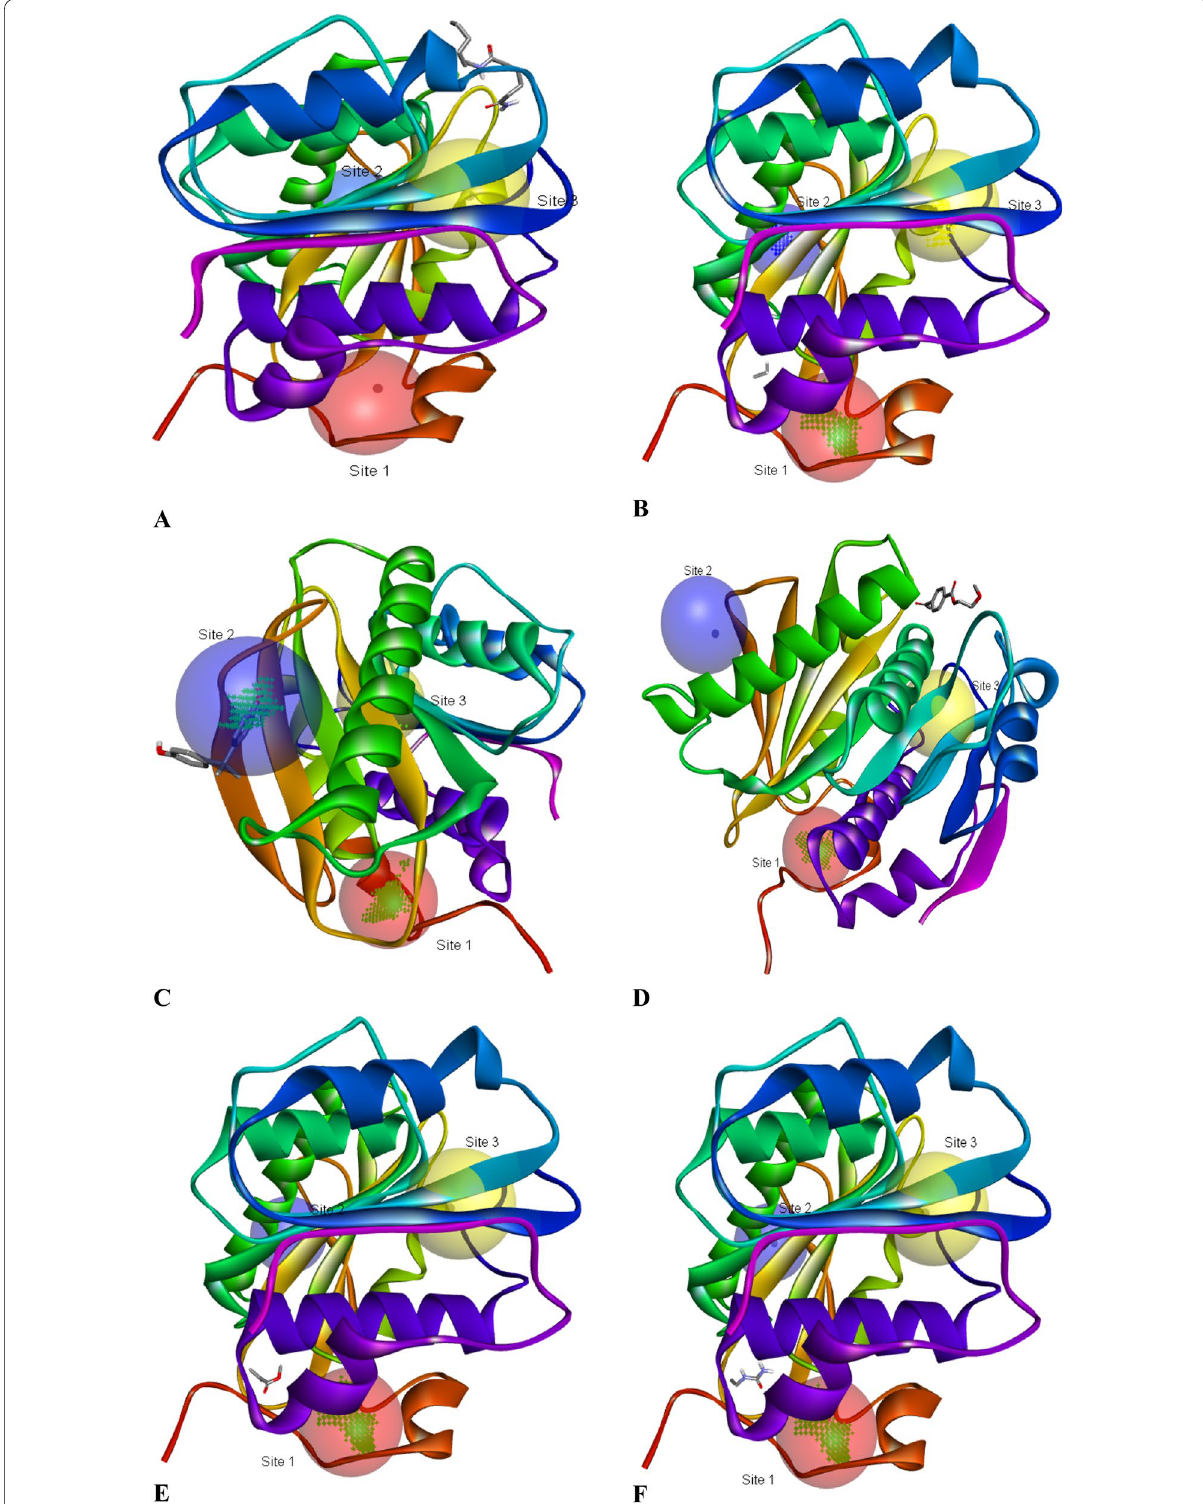
Fig. 1 Binding of microplastic compounds at different sites on I.